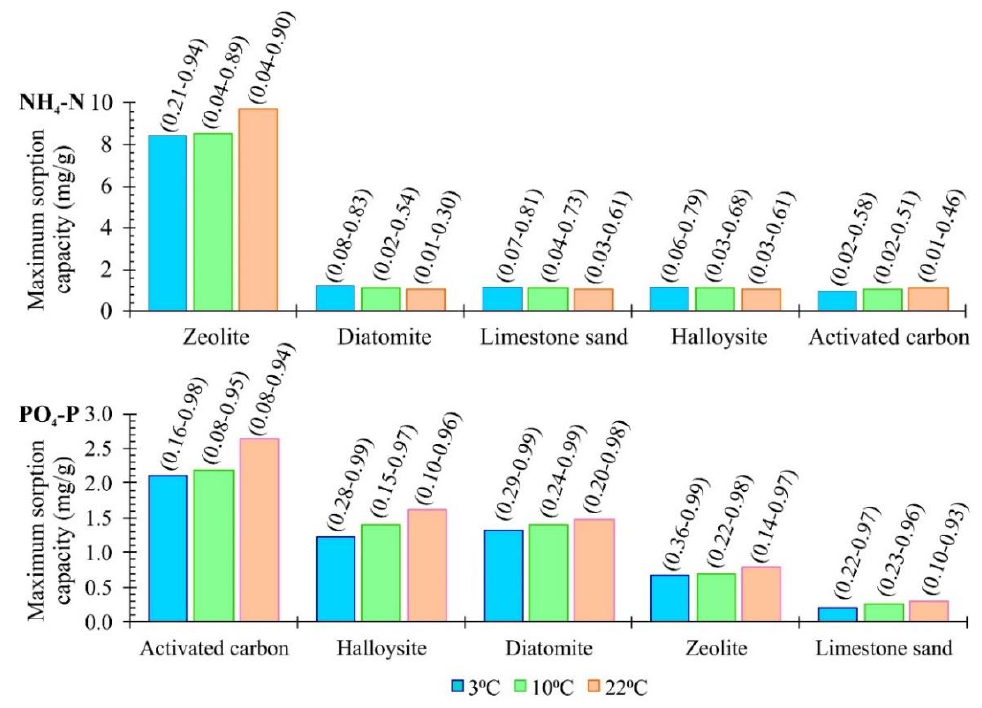
Figure 10. Maximum adsorption capacities of reactive materials with regard to NH 4 -N and PO 4 -P at 3 °C, 10 °C and 22 °C ( R L value ranges are presented in parentheses).